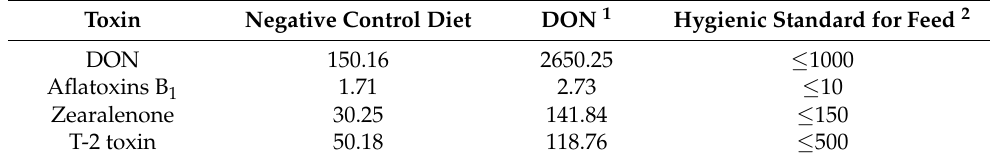
Table 2. Mycotoxin content in feed ( µ